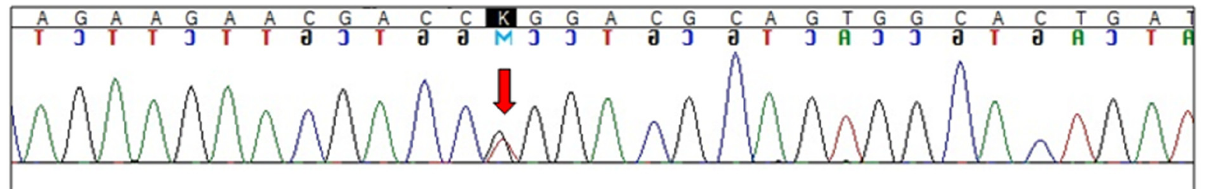
Figure 2. Gel-electrophoresis showing results of PCR test for deletion in the IKBKG gene (M—1 kB ladder; 1 and 2—positive controls; 3—negative control; 4—brother; 5—proband; 6—sister; 7— mother). Arrow indicates 1045 bp band present in case of deletion. The lower band represents 733 bp internal control. In column M is GeneRuler 1 kb DNA ladder (Thermo Scientific, USA, cat. No SM0311), with marked band size on the right. Figure 3. Electropherogram showing GBA L444R (c.1448T>G) mutation (arrow indicates heterozy- gous substitution).